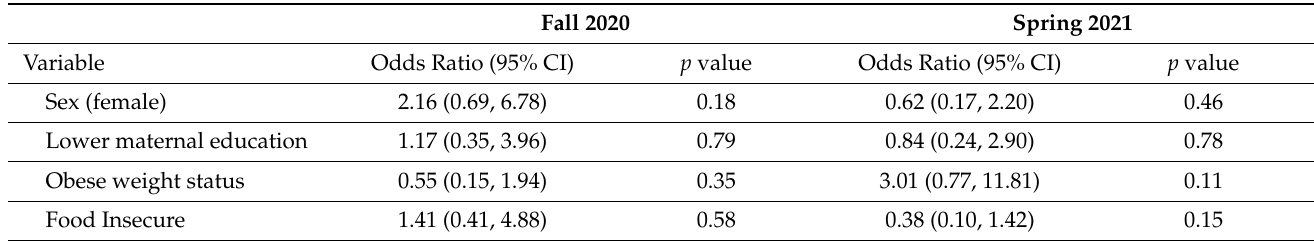
Table 5. Odds of high SSB